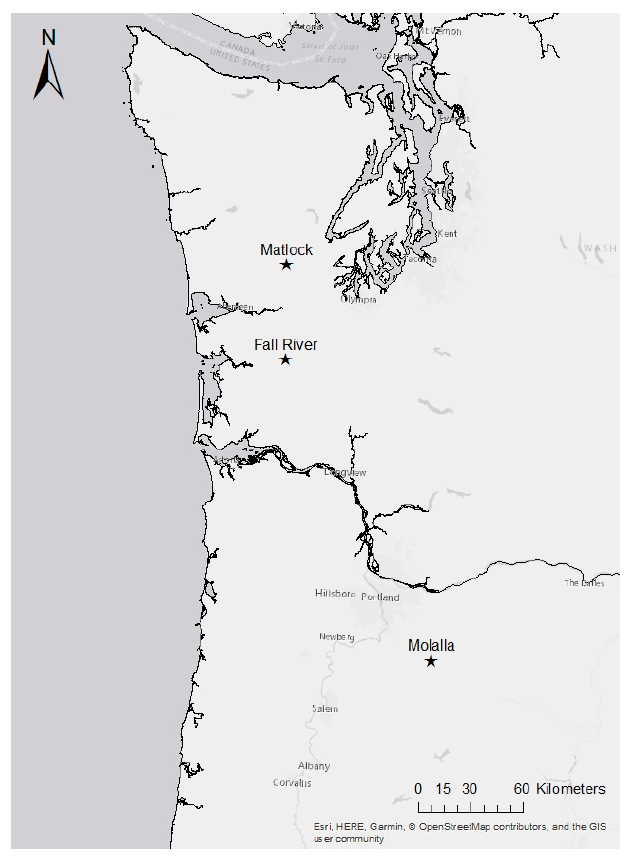
Figure 1. Three affiliate sites of the North American Long-term Soil Productivity study in Washington and Oregon, USA. Map is sourced from ArcGIS (ArcMap version 10.6, Esri, Redlands, CA, USA).